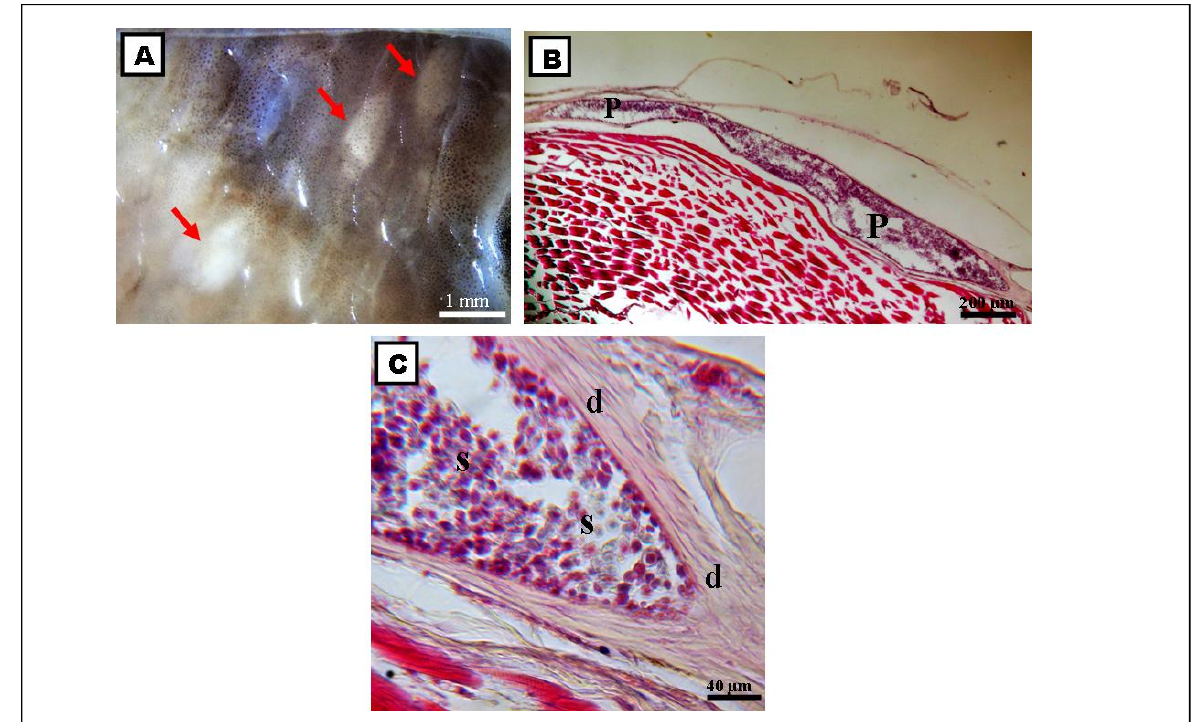
Figure 3: Microphotographs of plasmodia of Myxobolus dzeufieti sp. nov. developing in the skin of Oreochromis niloticus and Tilapia sp. Plasmodia implanted in the skin (red arrows) (A). Histological section of a portion of the skin bearing a plasmodium stained with haematoxylin and eosin (B). High magnifyed section of the skin showing the implantation of a plasmodium within the dermis (C). (d= dermis; p = plasmodium; s = spore).